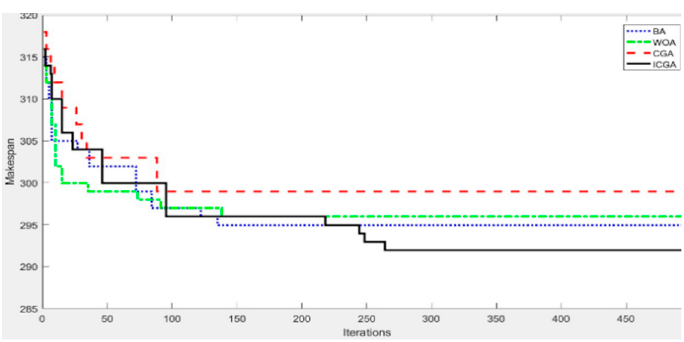
Figure 5. Relationship between fitness value and training iterations of schemes 5–8.